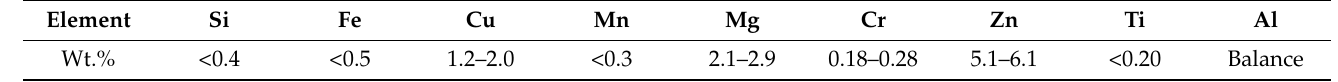
Table 1. Chemical composition of 7075 aluminum alloy (from the supplier).